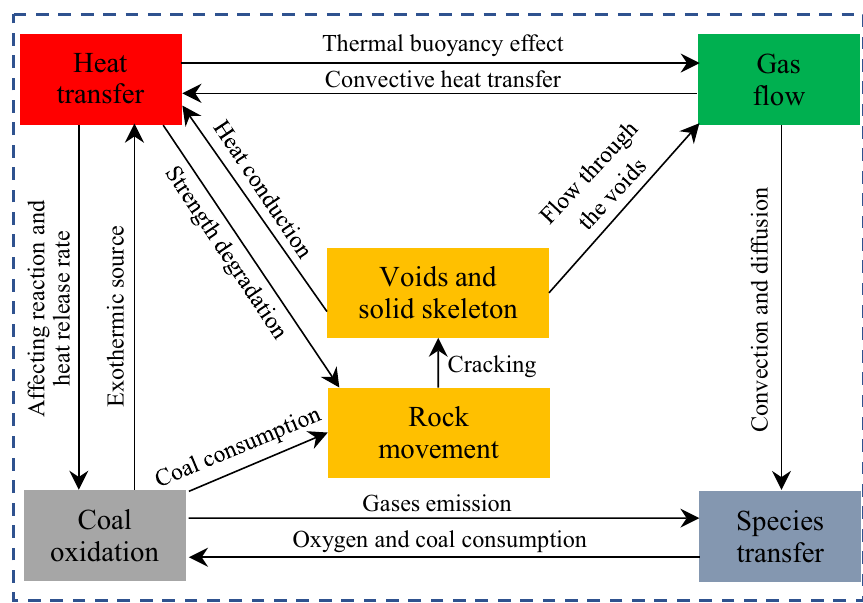
Fig. 7 Multiphysics coupling process of underground coal fires (Wang et al.